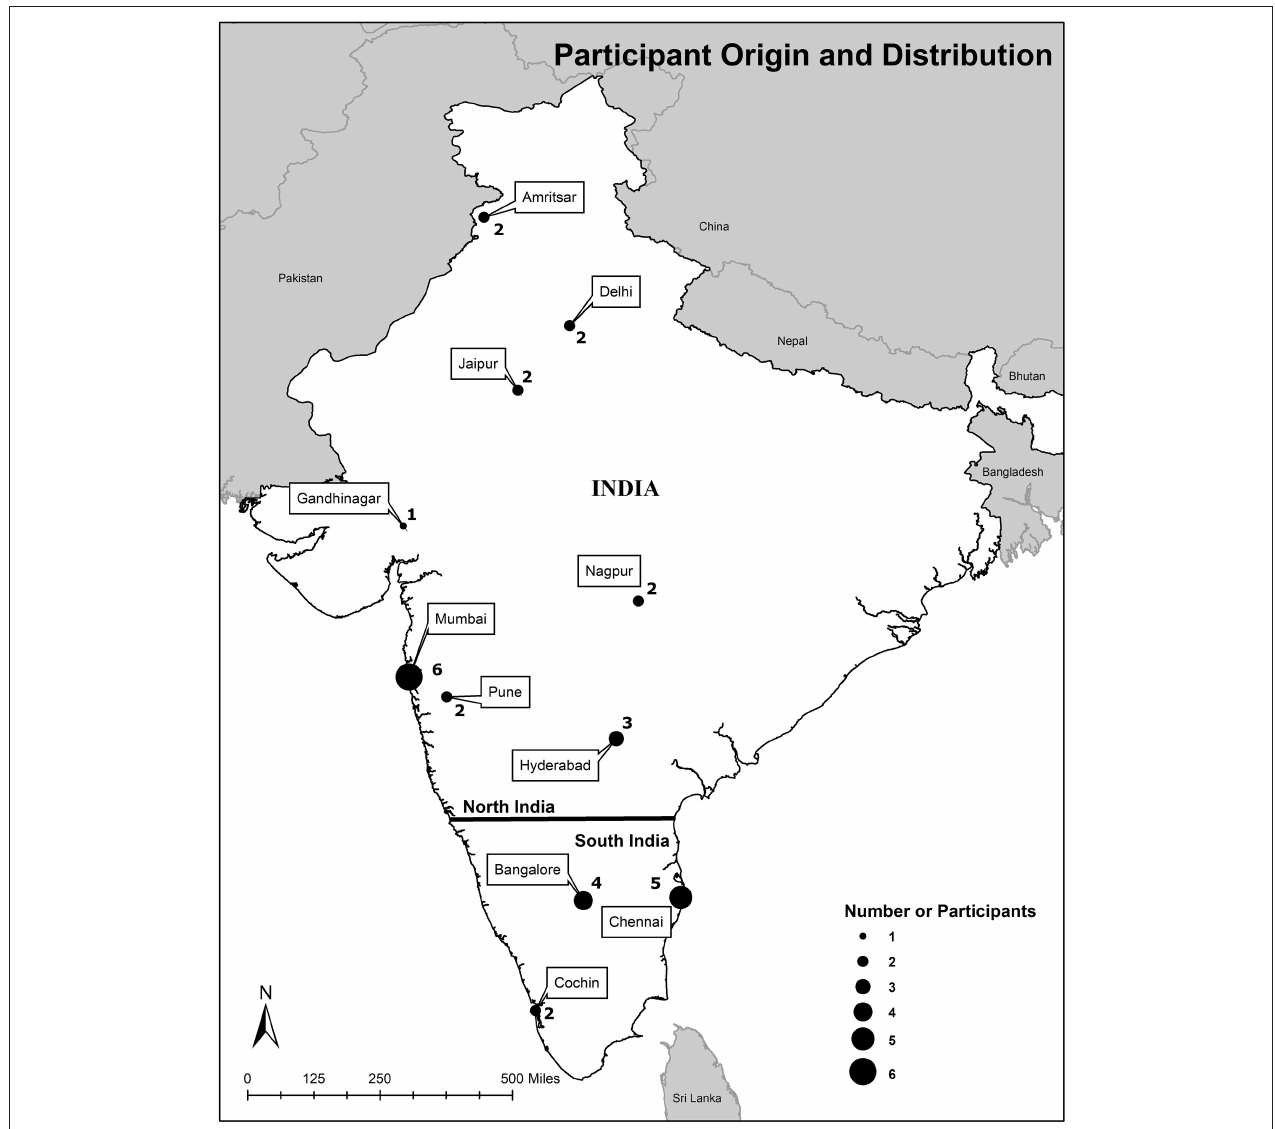
FIGURE 2 | Place of origin in India of 31 research